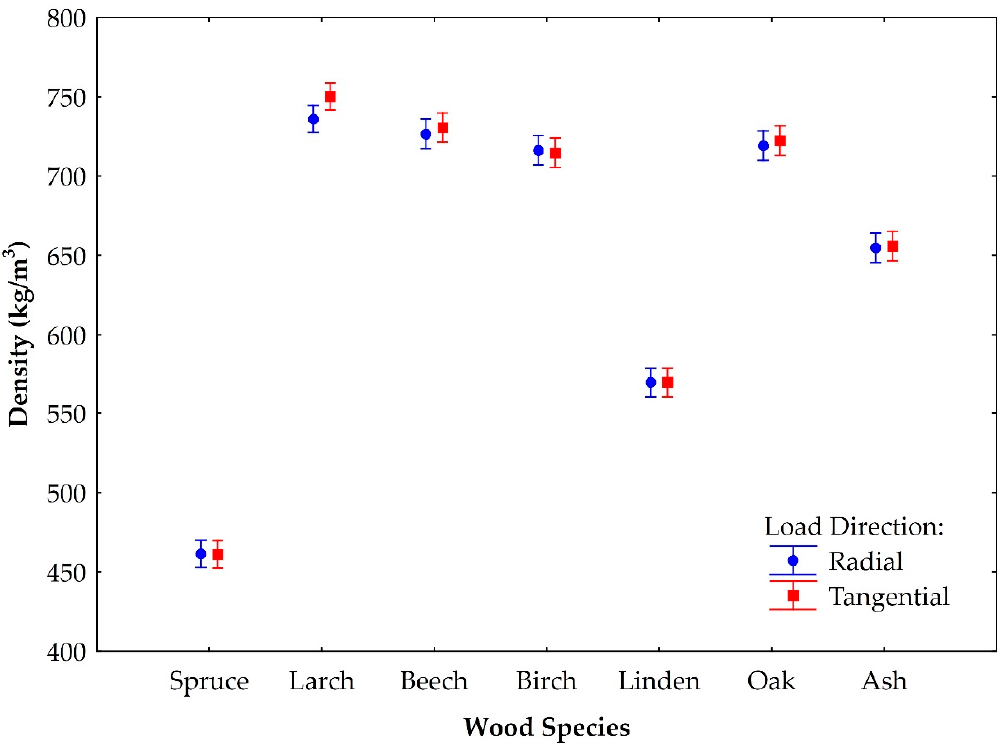
Figure 4. Graphic visualization of samples density of specific wood species for determination of the effect of load direction at bending strength and impact bending strength.